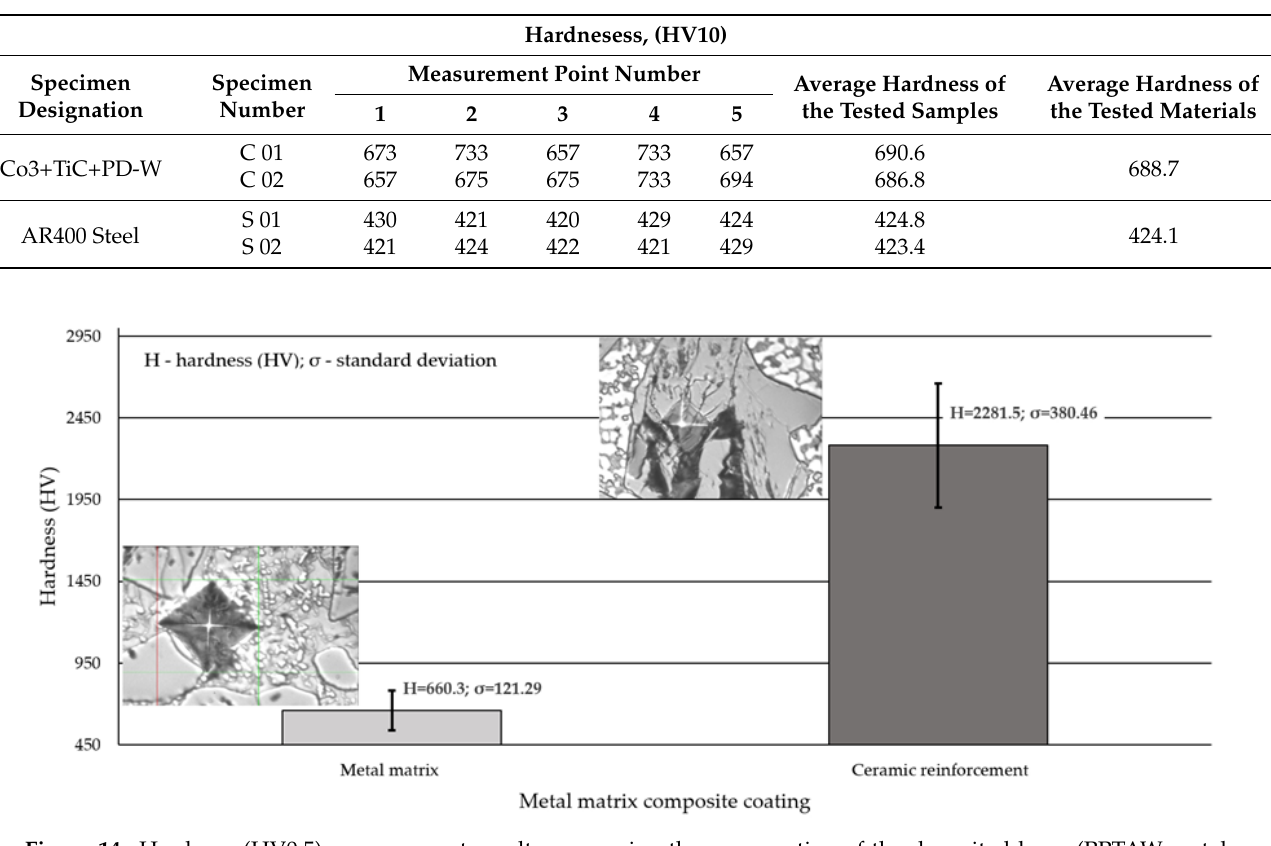
Figure 14. Hardness (HV0.5) measurement results concerning the cross-section of the deposited layer (PPTAW metal deposition method, Co3+TiC+PD-W composite powder) deposited on structural low-alloy steel AISI 4715.